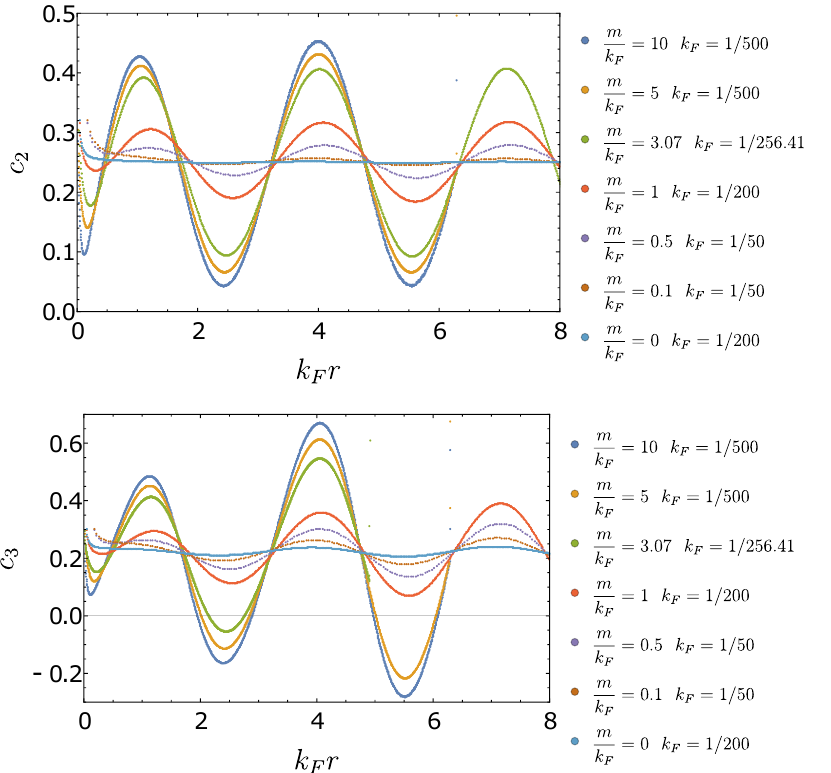
Figure 4 . c 2 and c 3 functions for all regimes of Dirac fermions at finite density. In all of them, except for m = 0 , there are Friedel oscillations of period π as a function of k F r .